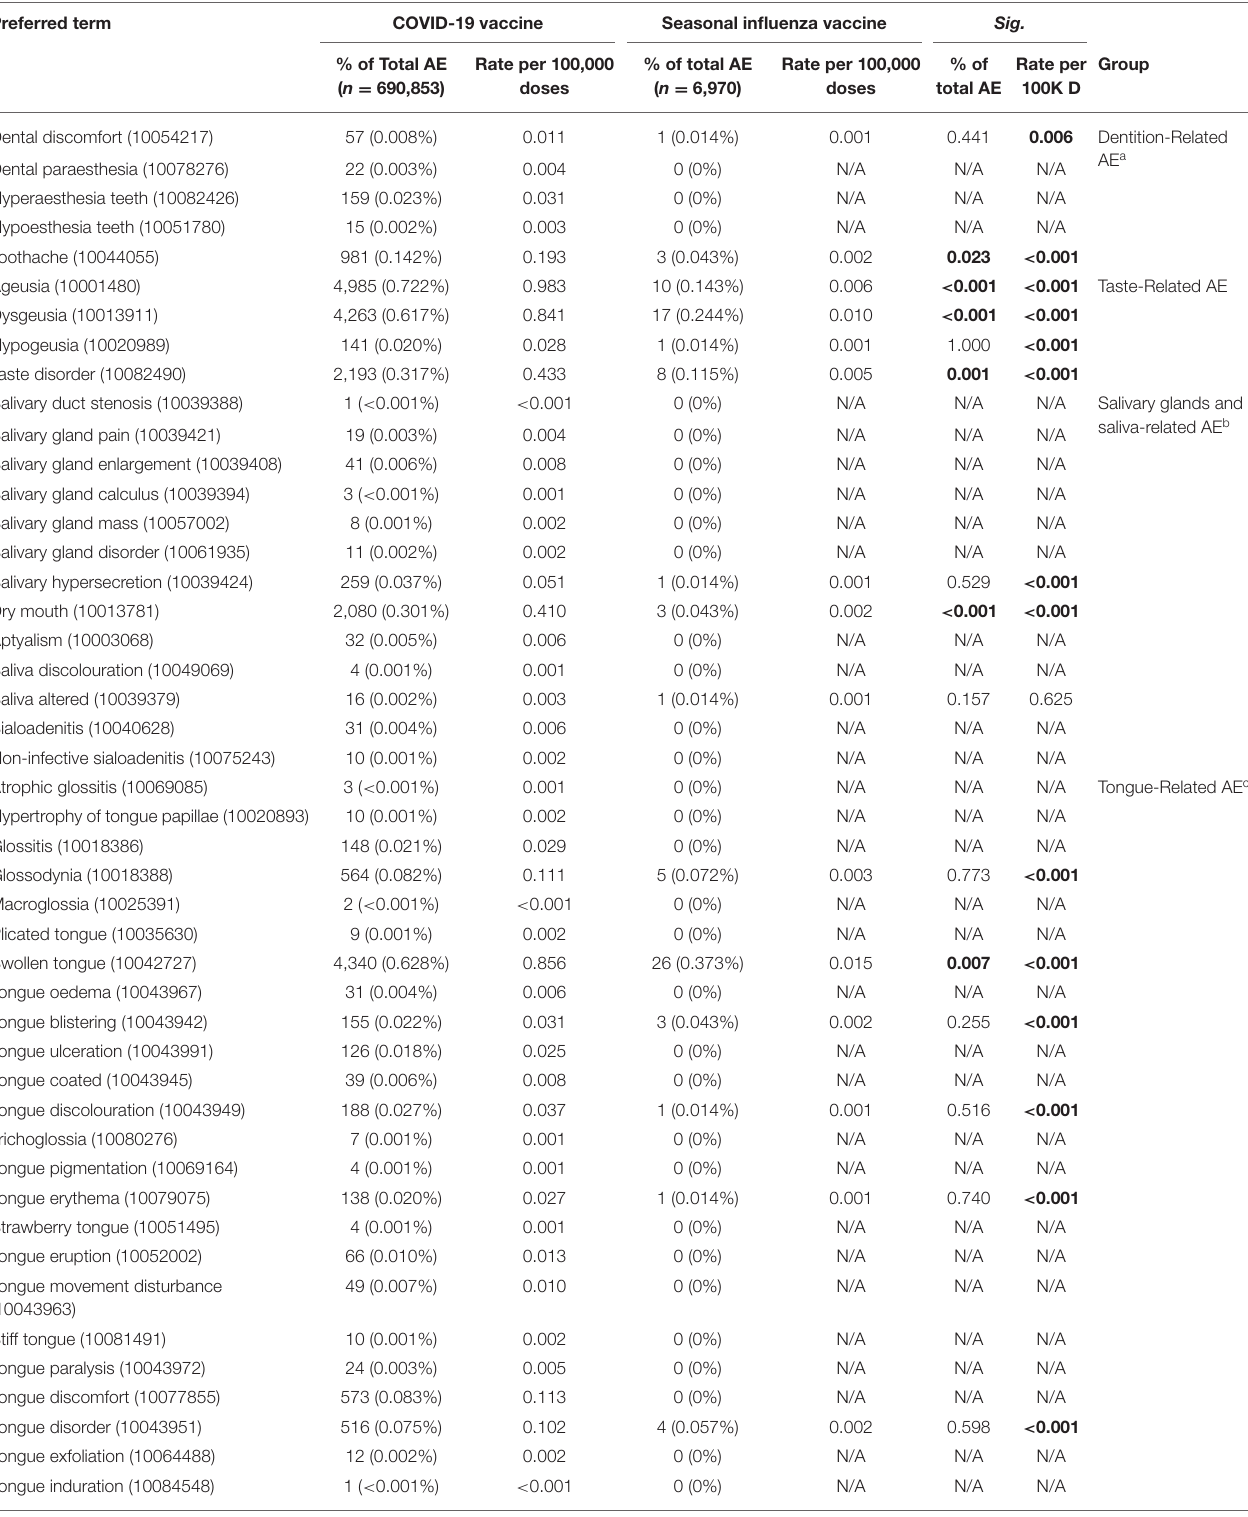
TABLE 2 | Oral adverse events reported after receiving COVID-19 and seasonal influenza vaccines in the United States, January–December 2021 (CDC; VAERS-WONDER). Preferred term COVID-19 vaccine Seasonal influenza